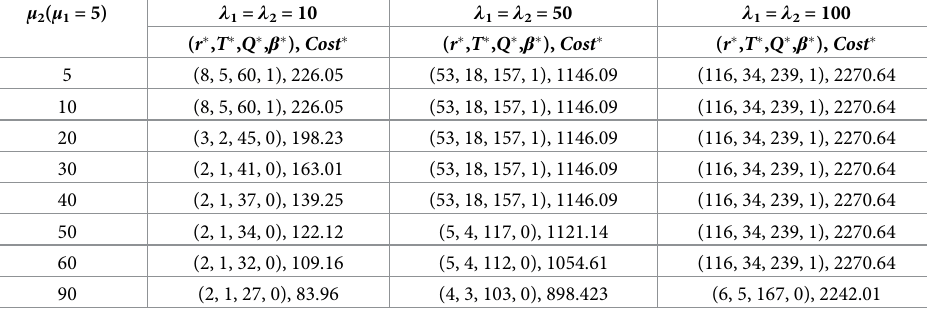
The � in the table represents the optimal